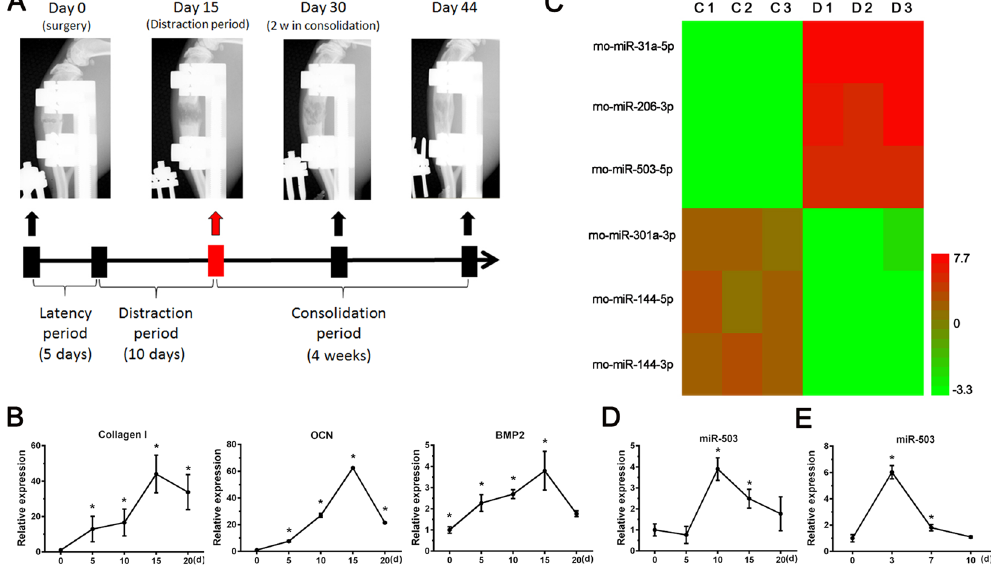
Figure 1. MiR-503 expression is increased during DO process and osteogenic differentiation. ( A ) Animal model of DO in rats. Bone formation was obvious in the distraction gap during distraction phase detected by X-ray. At the end of distraction phase, bone tissue from distraction gap were harvested for a microRNA microarray test. The contralateral tibiae were also harvested for normal control (n = 3 per group). ( B ) Expression level of Collagen I, OCN and BMP2 were detected by q-PCR with the bone samples harvested from distraction gap at different observation time points. Results showed that these osteogenic markers were increased in different degrees during the DO process (n = 3 per group, each time points, * P < 0.05 compared to Day 0, GAPDH was used as an internal reference). ( C ) Heatmap of microarray result. (Simplified version). The top three up/down regulated microRNAs were list in the result. Red color represents up regulation while green color represents down regulation. C represents control group, D represents distraction group (n = 3 each group). ( D ) MiR-503 expression during DO process. Animals received DO surgery were sacrificed at day 0, 5, 10, 15 and 20. Fold change of miR-503 expression level at different time points were calculated through compared to the expression level at day 0. (n = 3 each time points, * P < 0.05 compared to Day 0, U6 was used as an internal reference). ( E ) MiR-503 expression in rBMSCs during osteogenic differentiation. Osteogenic induction was performed in rBMSCs. Cells were harvested at day 0, 3, 7 and 10. Fold change of miR-503 expression at different time points were calculated through compared to the expression level at day 0. (n = 3 each time points, * P < 0.05 compared to Day